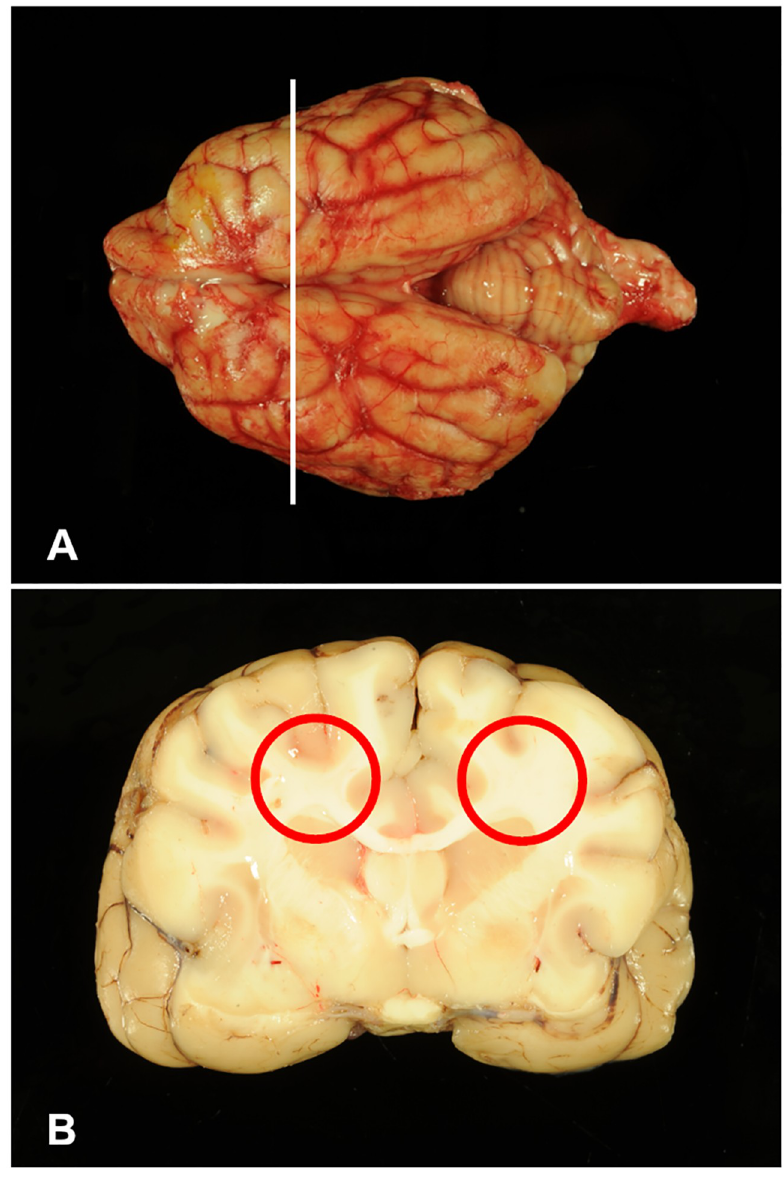
Fig 2. Macroscopic overview. (A, B) Age matched healthy control no. 1009. (A) Dorsal view on cerebrum, cerebellum and brainstem with section plane (white line). (B) Cross section of cerebrum showing the centrum semiovale (red